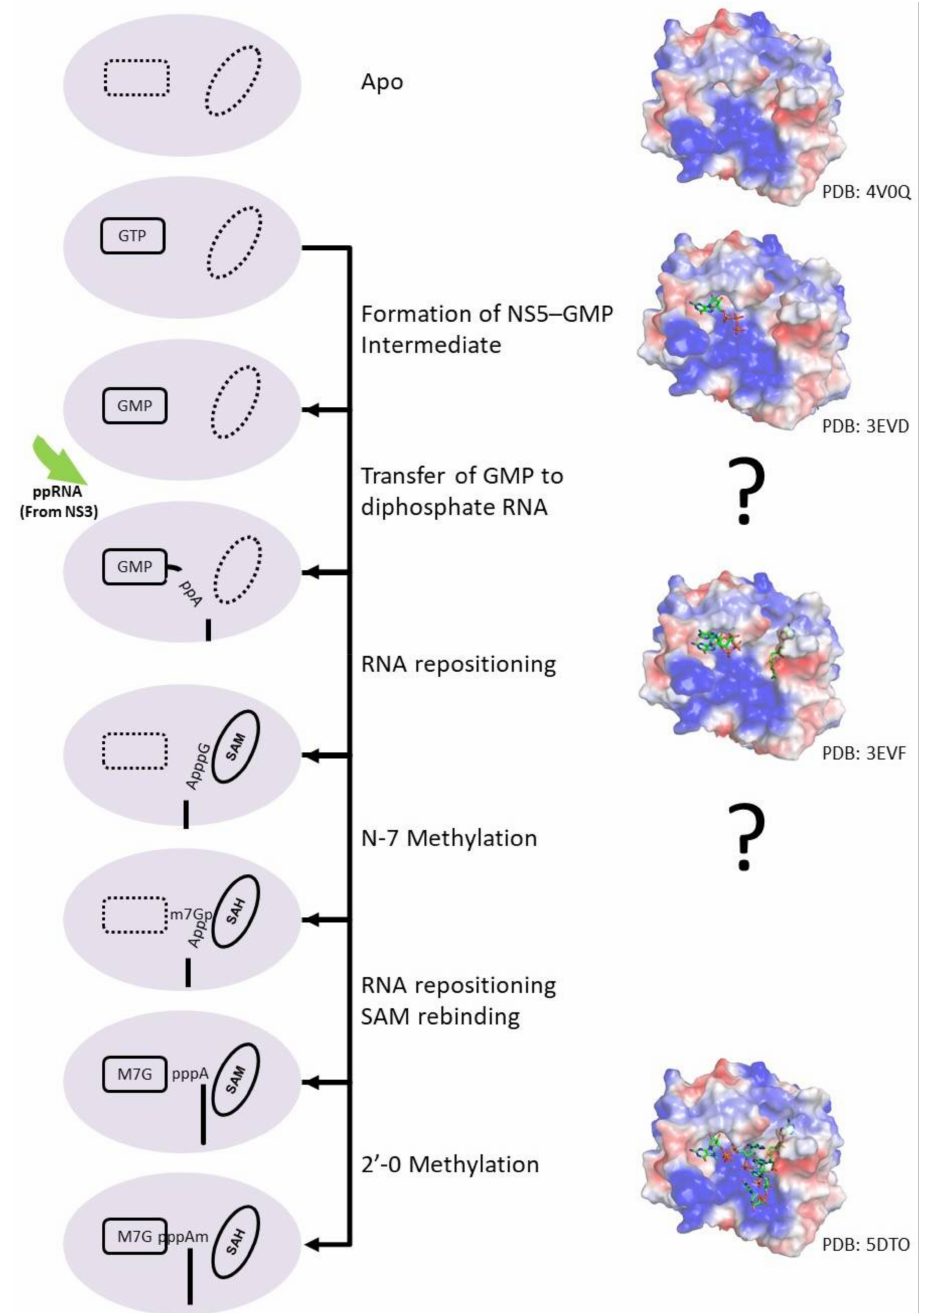
Figure 5. Cartoon representation of the flavivirus capping process. During the RNA capping process, GTP binds to the GTP binding pocket of NS5 and forms an NS5–GMP intermediate. Concurrently, NS3 RTPase removes phosphate from the viral genome to form a diphosphorylated RNA product. The NS5–GMP intermediate subsequently transfers the GMP to the diphosphorylated RNA upon RNA binding. Then, GpppA-RNA reposition the guanosine near the SAM binding site for N7- methylation. The SAH molecule is replenished by a SAM molecule while the N7M GpppA-RNA undergoes another repositioning to allow the initiating adenosine to be positioned near the SAM binding site for 2 (cid:48) O methylation to generate N7M GpppA 2 (cid:48) OM -RNA. Representative protein structures with their PDB codes are also